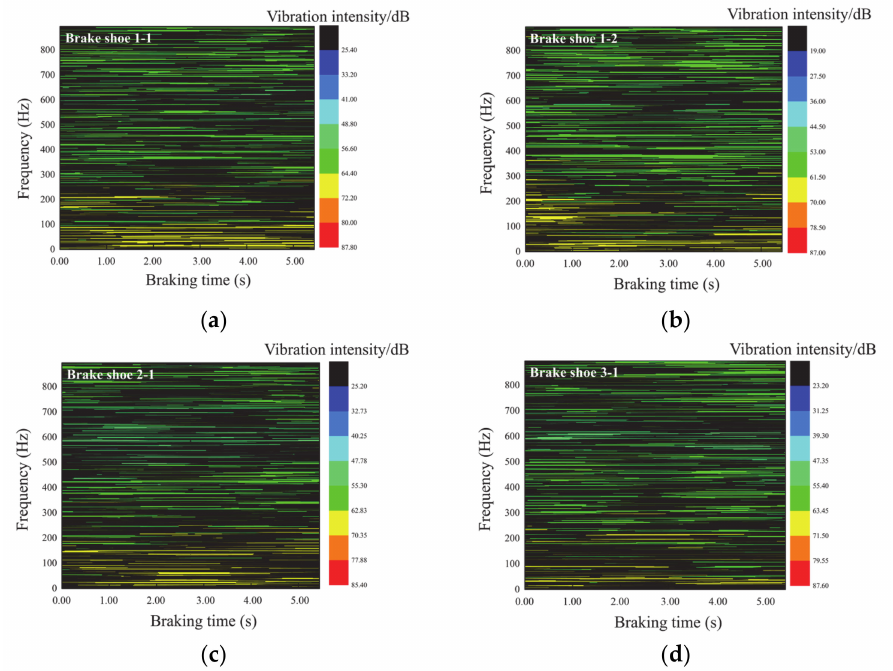
Figure 7. Vibration frequencies of brake shoes 1-3. ( a ) Brake shoe 1-1 ( b ) brake shoe 1-2 ( c ) brake shoe 2-1 ( d ) brake shoe